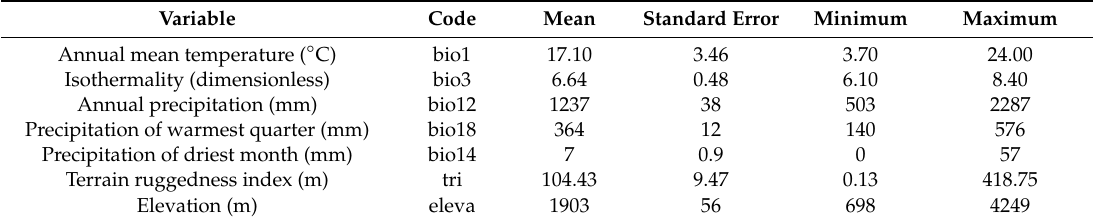
Table 2. Environmental variables used to model distribution of P.